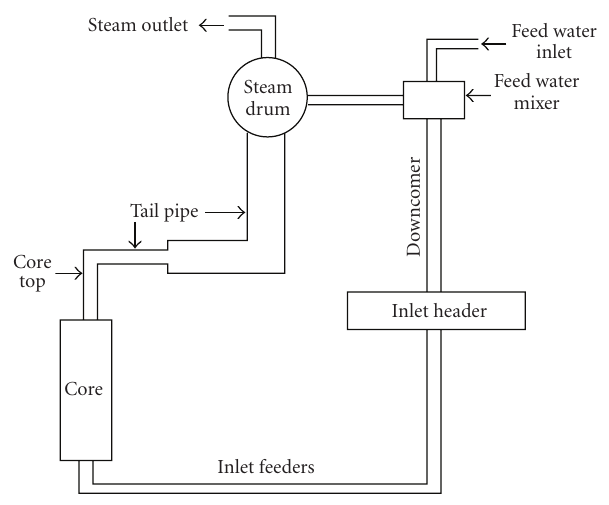
Figure 1: Schematic diagram of NCBWR.